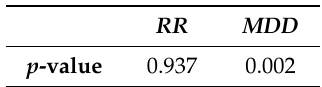
Table 13. The p -value of the conducted Wilcoxon tests of comparing the RR and MDD of IDBA and